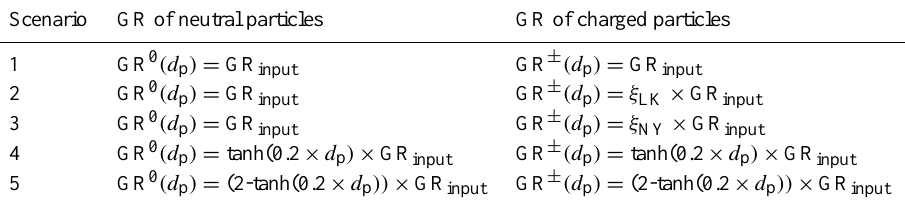
Table 1. The values of parameters used as input in the model. Parameter Values used as input in the model Particle diameter growth rate (nm h − 1 ) 1; 3; 6; 10 New particle formation rate (cm − 3 s − 1 ) 0.0001; 0.1; 1; 3; 10 Concentration of 150-nm particles (cm − 3 ) Corresponding condensation sink (s − 1 )